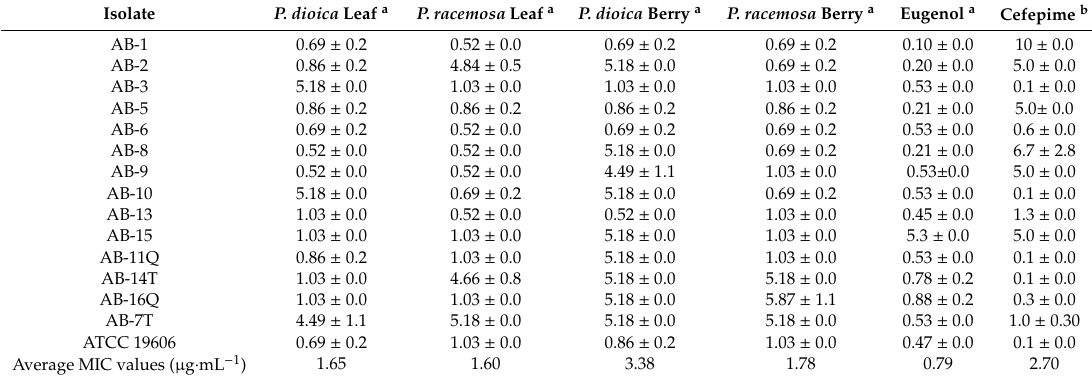
Table 1. The minimum inhibitory concentration values (MIC), in µ g · mL − 1 , of tested Pimenta essential oils, eugenol, and cefepime antibiotic tested against the clinical isolates of Acinetobacter baumanii (AB), the results are represented as the mean of three replicates ± standard deviation.